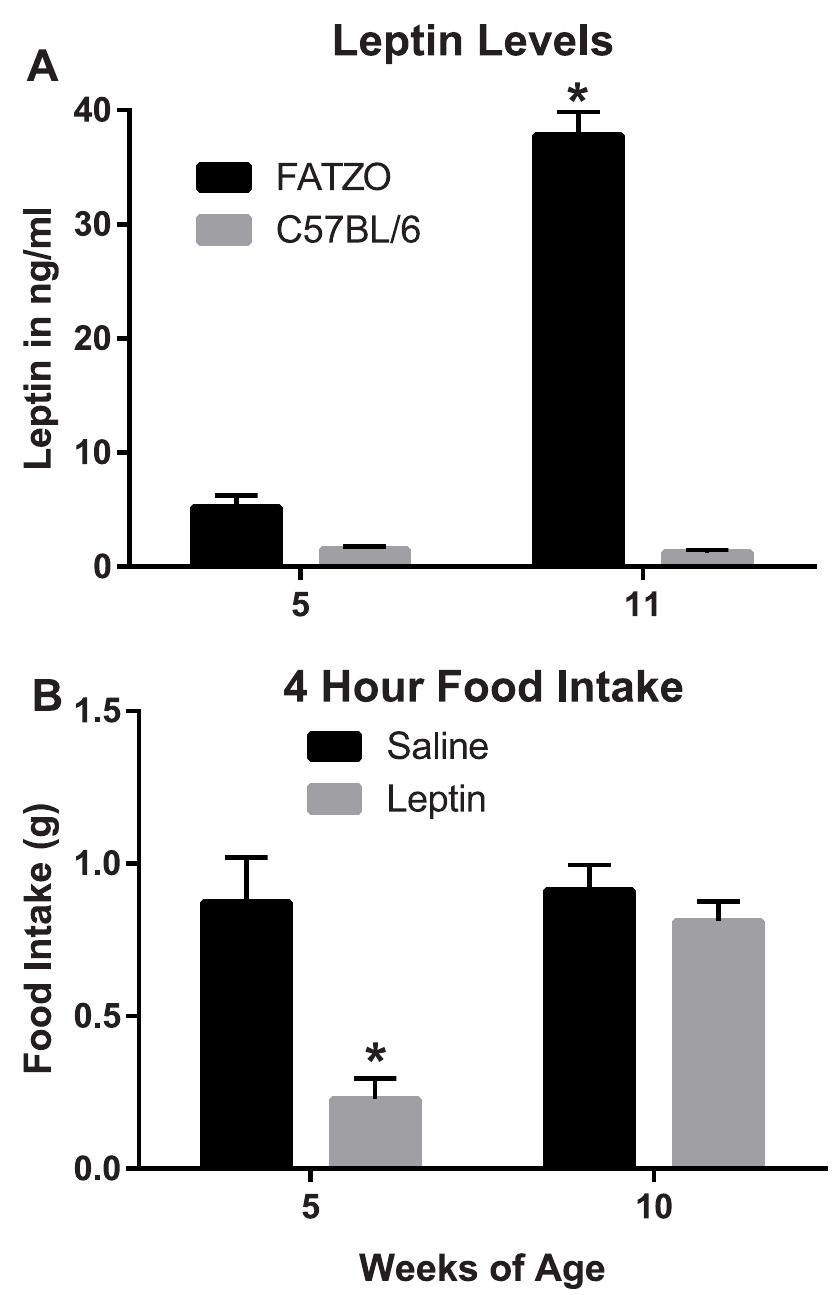
Fig 5. Leptin levels and the effect of leptin on food intake. Leptin levels (A) and the effect of leptin on food intake (B) at two ages are illustratedin this figure (one-way ANOVA followedby Sidak’smultiple comparison tests). Statistical differences from the other groups are denotedat p < .001( ** )and p < .0001( ***